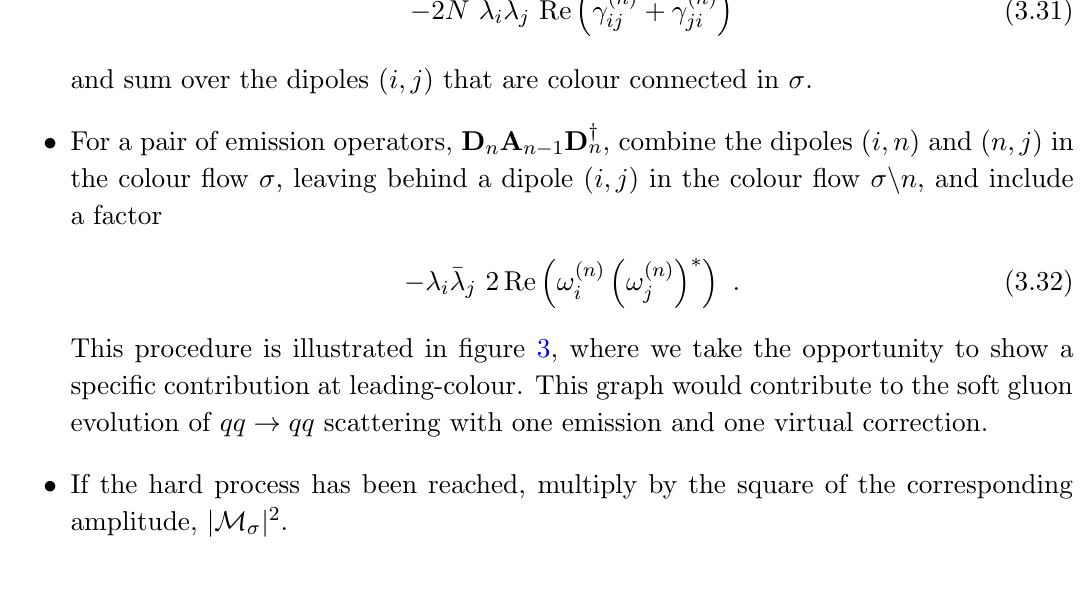
Figure 3 . An example to illustrate colour-(cid:13)ow evolution. In this case, we consider the leading- colour contribution, with one real emission and one virtual correction, to [ (cid:28) dashed lines indicate that it is possible to read o(cid:11) the colour-(cid:13)ow map at any time during the evolution. See the text for the corresponding